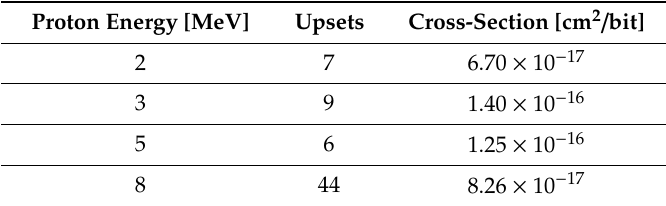
Table 4. Experimental SEU results.